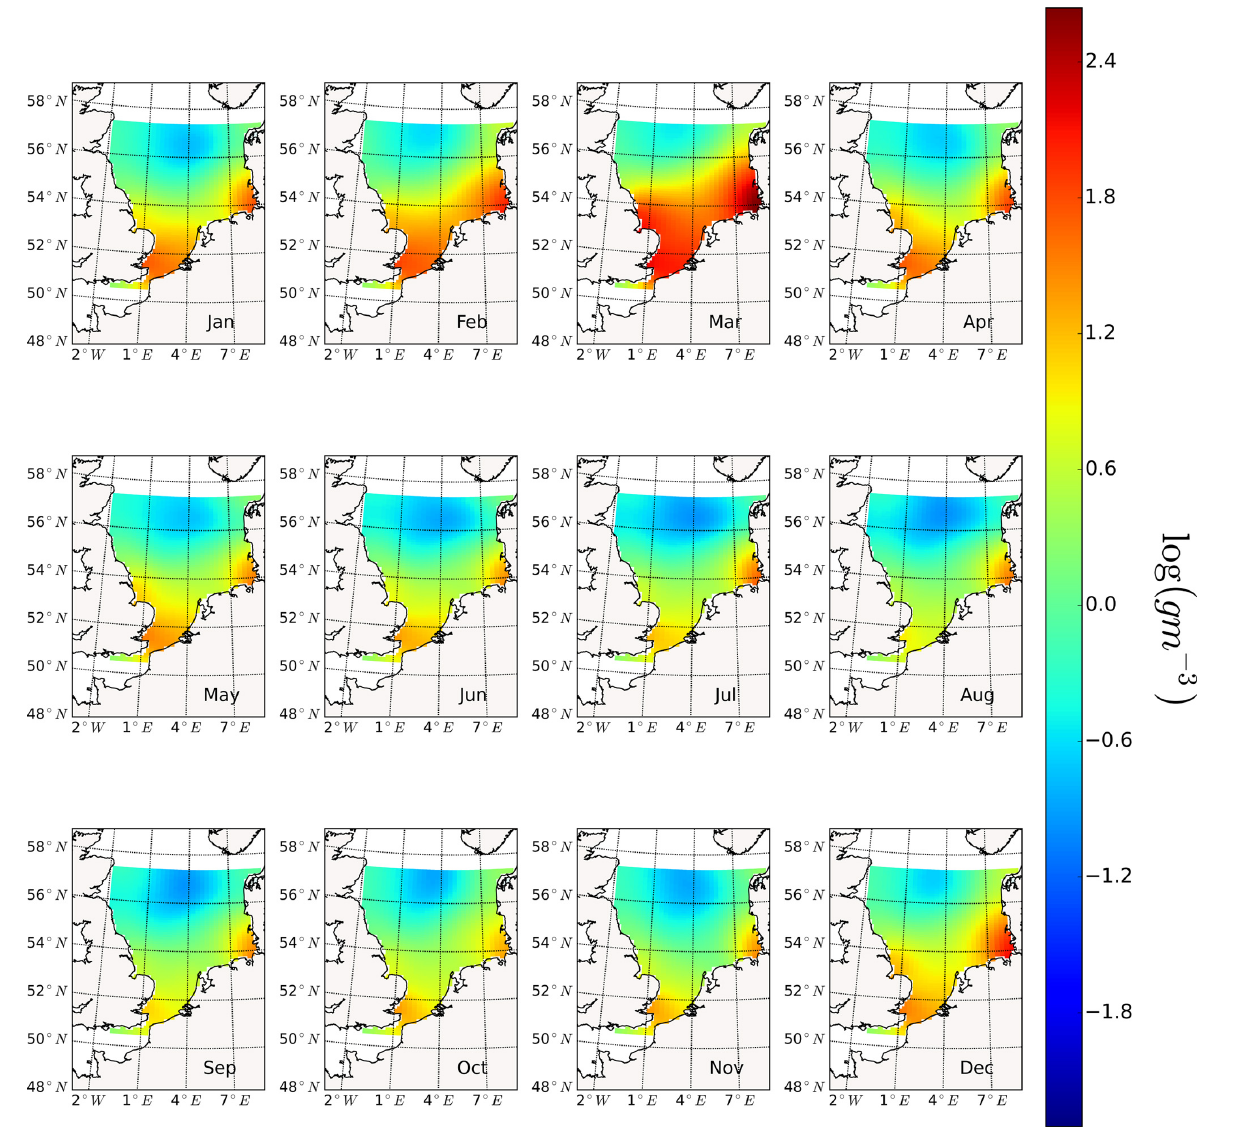
Figure C1. Monthly mean of inorganic SPM concentration in the first layer (upper